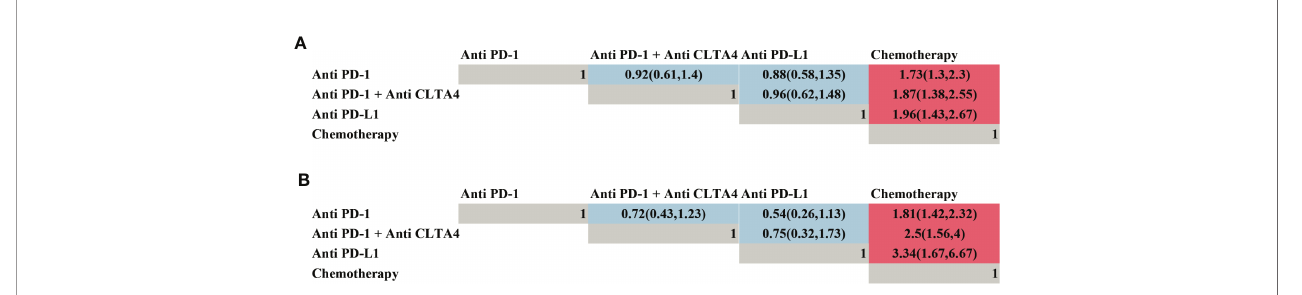
FIGURE 5 | Ef fi cacy of different types of immune checkpoint inhibitor pro fi les based on overall survival (A) and progression-free survival (B) . Each cell of the ef fi cacy pro fi les contains the pooled hazard ratio and 95% con fi dence intervals; signi fi cant results are in red, otherwise, in blue. The pooled hazard ratio and 95% con fi dence intervals indicate the results of the column name compared with the